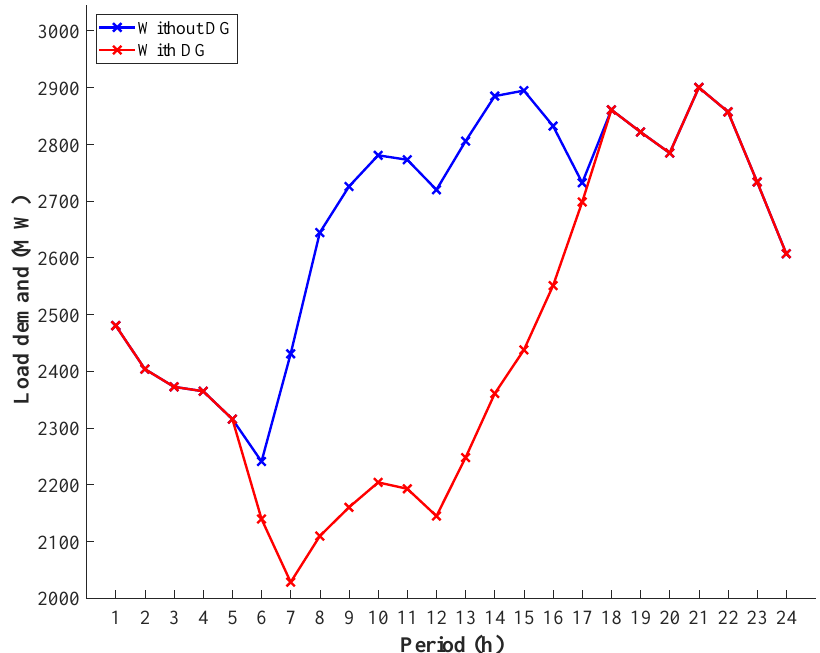
Figure 6. Load demand curve along the day with and without Distributed Generation (DG). Data source: